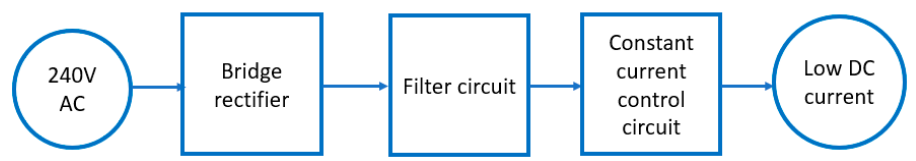
Figure 4. Schematic of the working principle of the LED drive circuit.